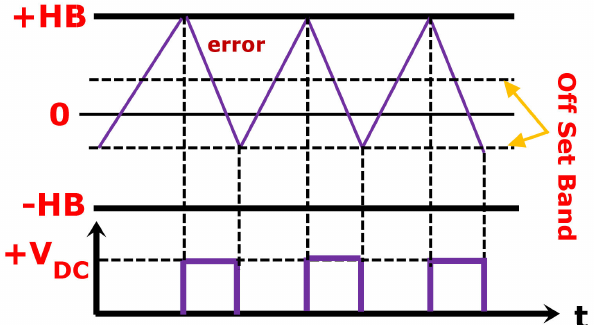
Figure 7. Analysis of offset hysteresis band current controller with positive inverter output